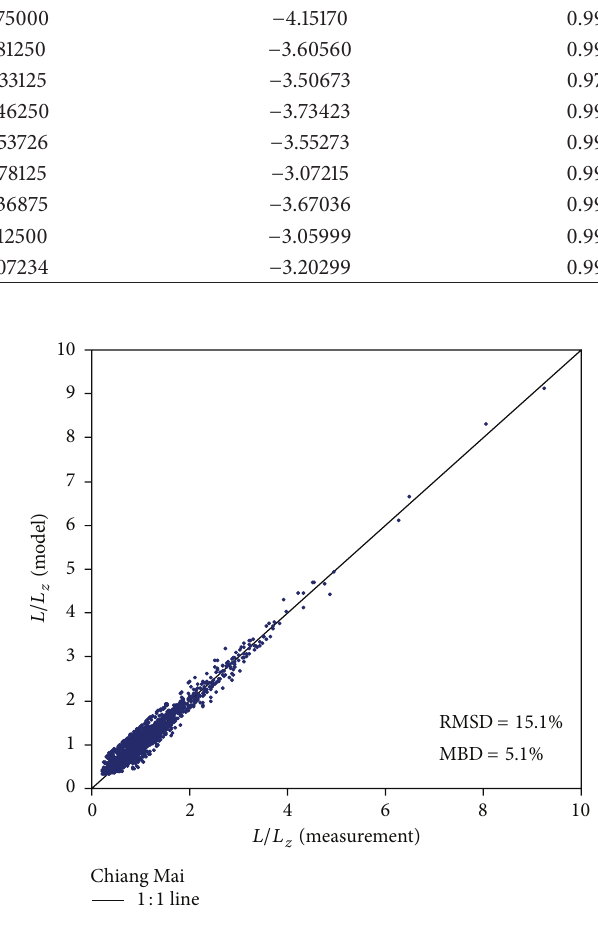
Figure 12: Comparison between the relative sky luminance cal- culated from the 𝐿/𝐿 𝑧 model and that obtained from the 𝐿/𝐿 𝑧 measurement for Chiang